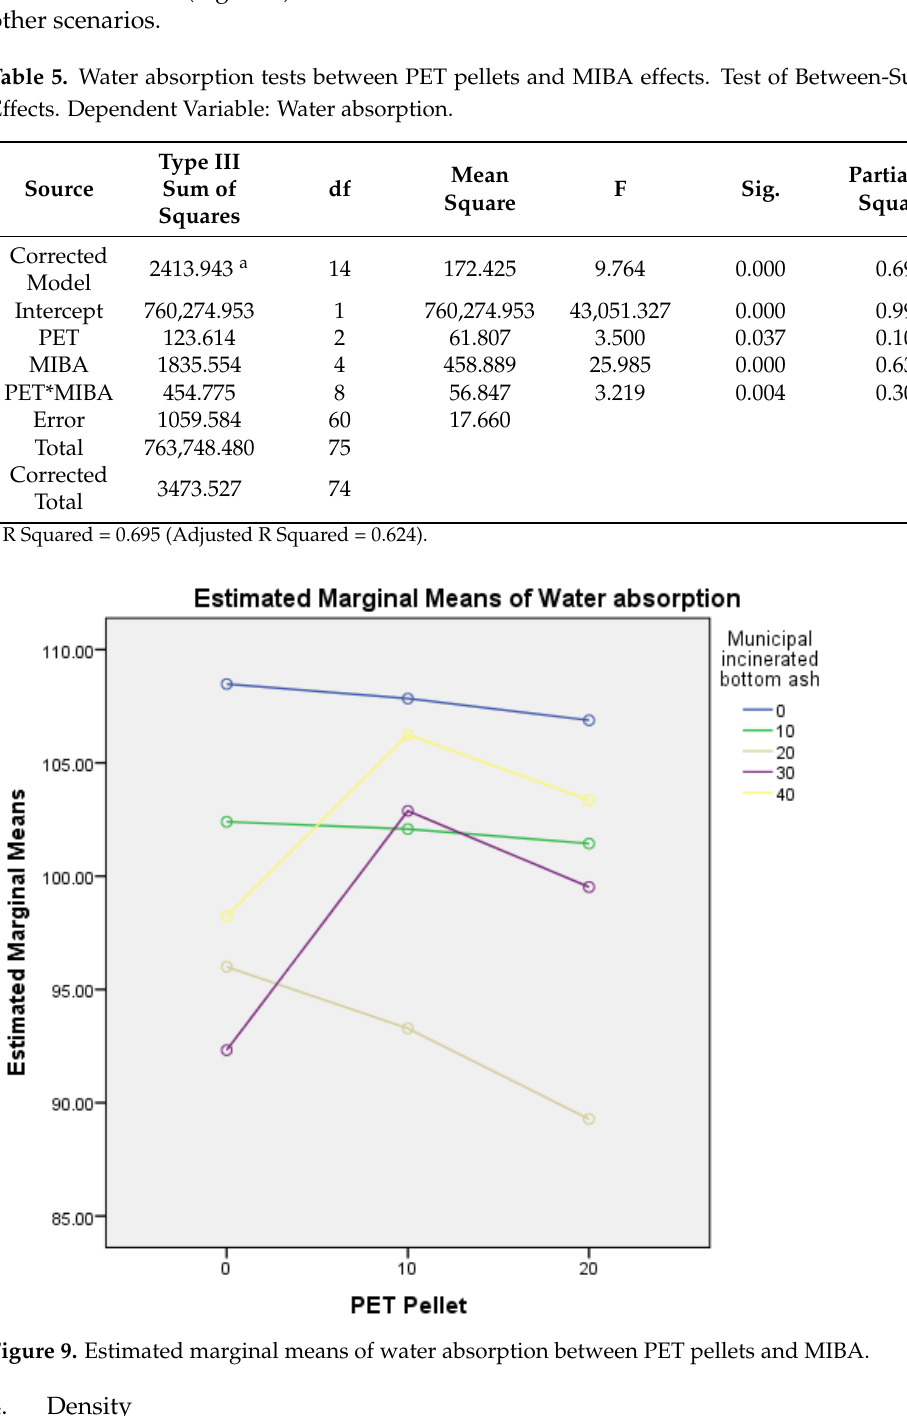
Table 5. Water absorption tests between PET pellets and MIBA effects.